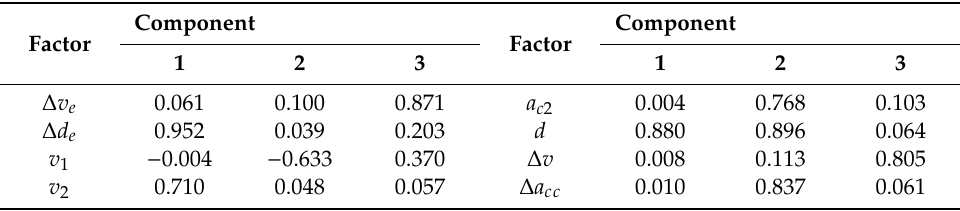
Table 5. Rotated factor matrix.